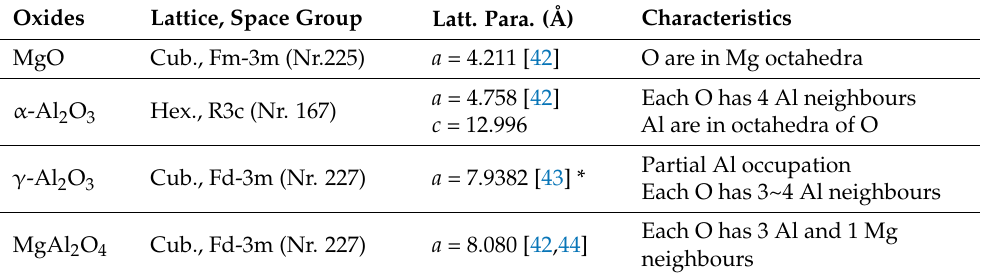
Table 1. Crystal properties of MgO, α -Al 2 O 3 , γ -Al 2 O 3 and MgAl 2 O 4 spinel.